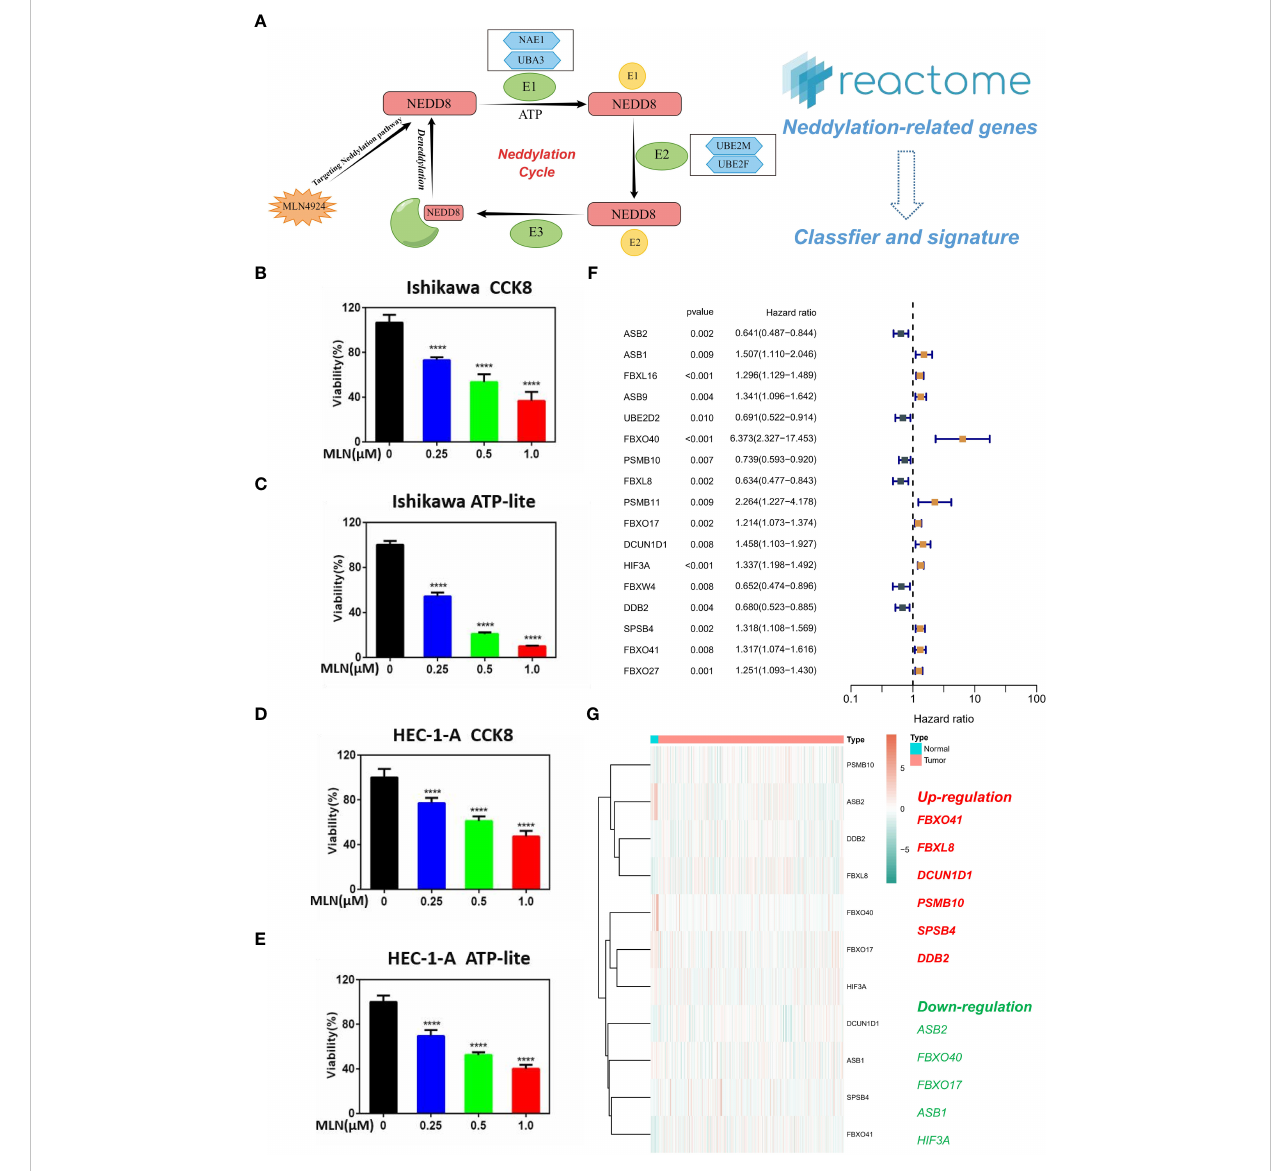
FIGURE 1 Key role of neddylation-related pathway in EC. (A) Process of neddylation modi fi cation. (B, C) MLN4924 signi fi cantly inhibited the proliferation of Ishikawa cell. (D, E) MLN4924 signi fi cantly inhibited the proliferation of HEC-1-A cell. (F) Univariate Cox analysis of neddylation-related genes in TCGA-UCEC cohort. (G) Expression landscape of 17 prognostic NRGs. ****p <